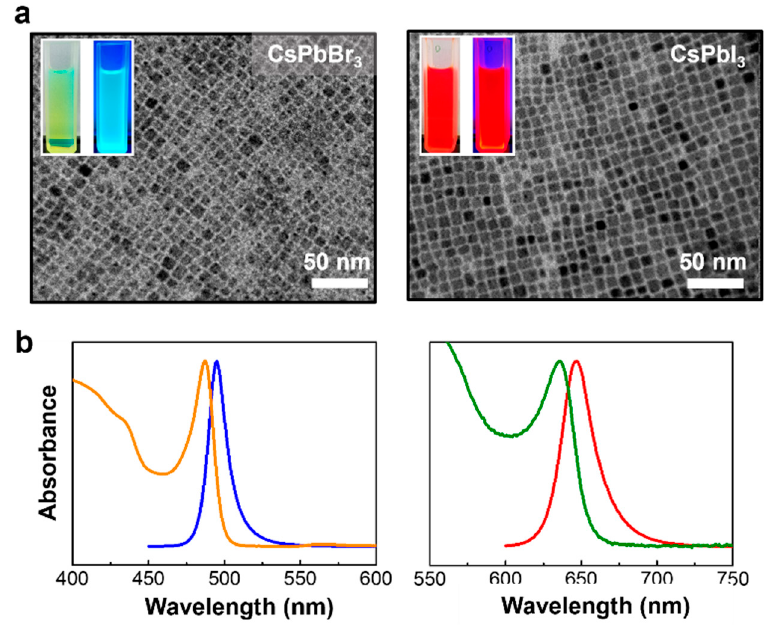
Figure 1. Inorganic metal halide perovskite QDs via hot-injection approach with zinc halide salt at 160 ◦ C. ( a ) Typical TEM images of CsPbBr 3 and CsPbI 3 QDs synthesized using ZnBr 2 and ZnI 2 as an excess of halide ions, respectively. Insets show digital images of CsPbBr 3 and CsPbI 3 QDs dispersed in toluene solvent, which is illuminated under irradiation with an excitation wavelength of 365 nm. ( b ) Absorption (orange line of CsPbBr 3 and green line for CsPbI 3 QDs) and corresponding PL spectra (blue line of CsPbBr 3 and red line of CsPbI 3 QDs) shows emission center of 495 and 647 nm, respectively; excitation wavelength was 350 nm.